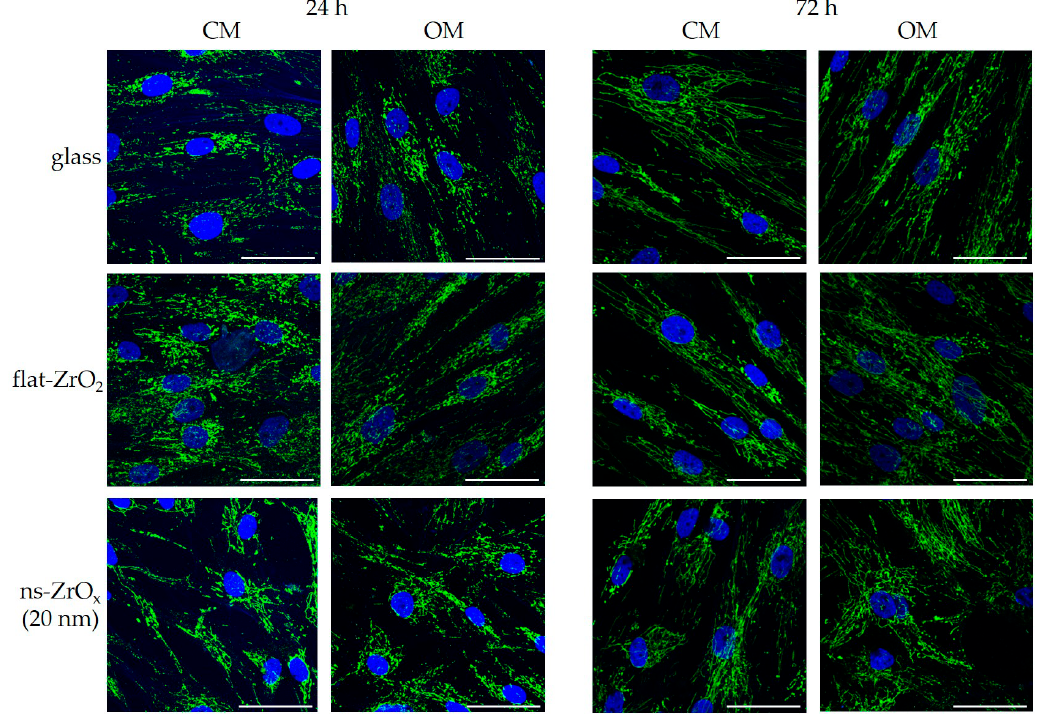
Figure 7. The effect of 20 nm ns-ZrOx on the mitochondrial network. bMSCs were cultured in CM Figure 7 . The effect of 20 nm ns ‐ ZrOx on the mitochondrial network. bMSCs were cultured in CM or OM on 20 nm ns ‐ ZrOx, flat ‐ ZrO 2 , and glass. After 24 and 72 h, they were observed via confocal or OM on 20 nm ns-ZrOx, flat-ZrO 2 , and glass. After 24 and 72 h, they were observed via confocal microscopy after cyclophilin F and DAPI staining. Scale bar: 50 μ m. microscopy after cyclophilin F and DAPI staining. Scale bar: 50 µ m.